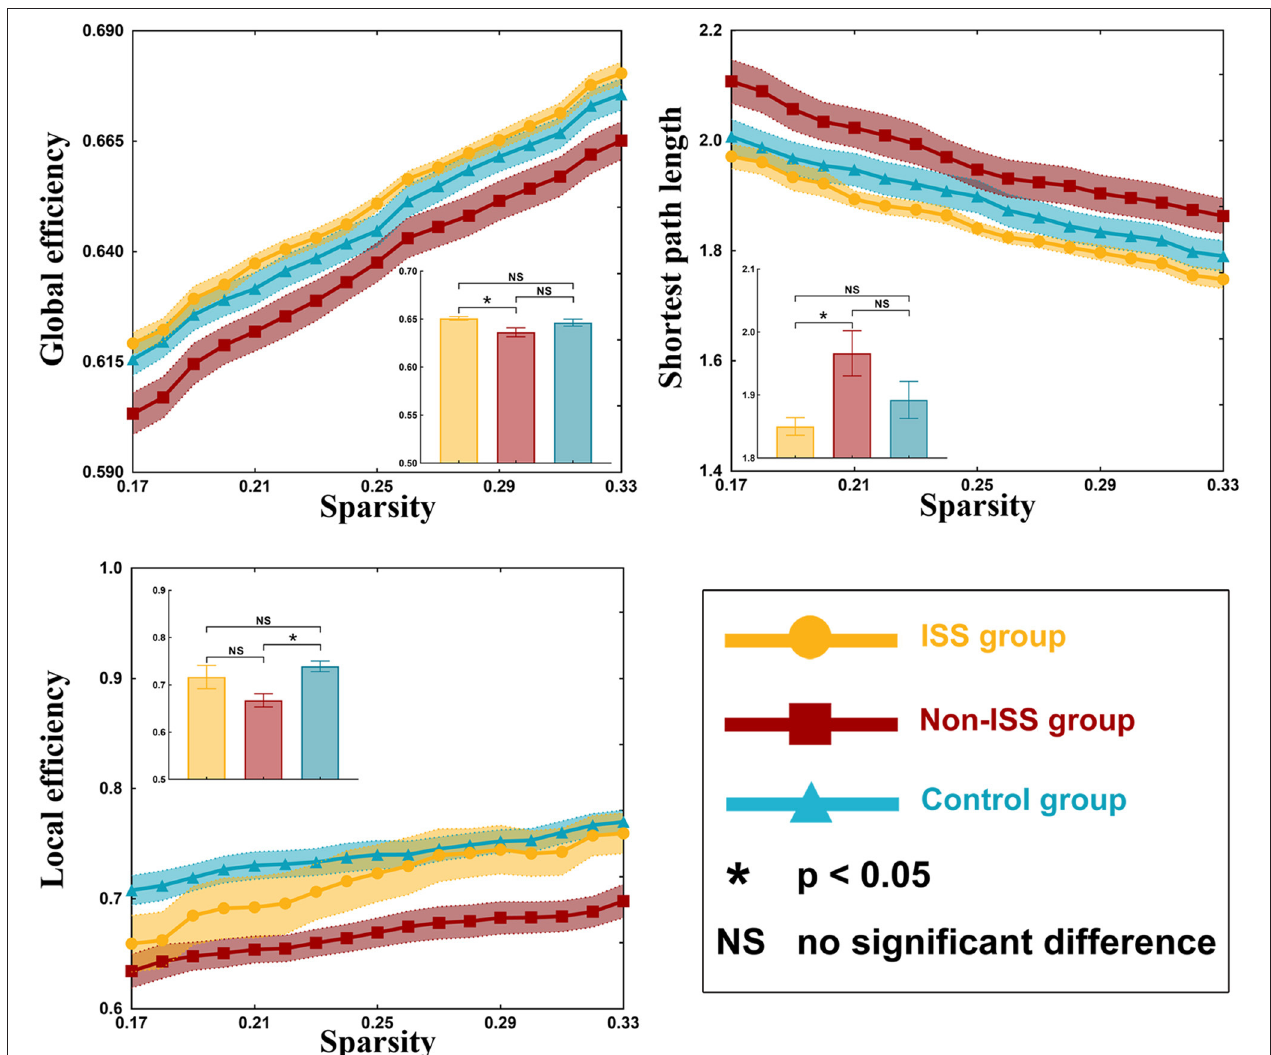
FIGURE 2 | Global properties of the ISS, non-ISS, and healthy groups. ISS, group of patients with intraoperative stimulation-induced seizures; Non-ISS, group of patients without intraoperative stimulation-induced seizures.